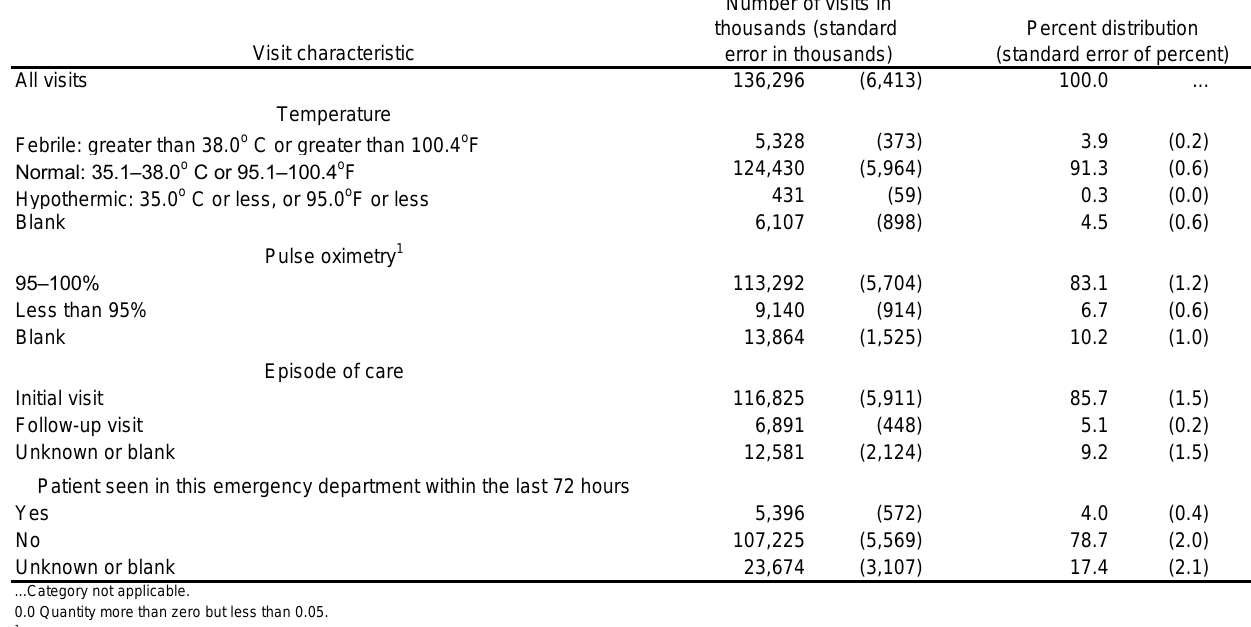
Table 9. Initial temperature, pulse oximetry, and visit history at emergency department visits: United States, 2011